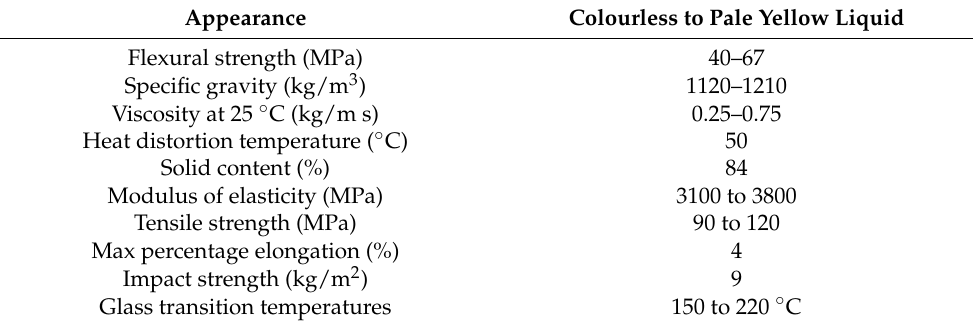
Table 1. Physical and mechanical properties of epoxy resins [17–20]